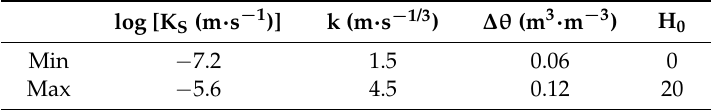
Table 2. Boundary values of each parameter of interest. Initial values of each parameter are drawn within these boundary values at the beginning of the fitting process.